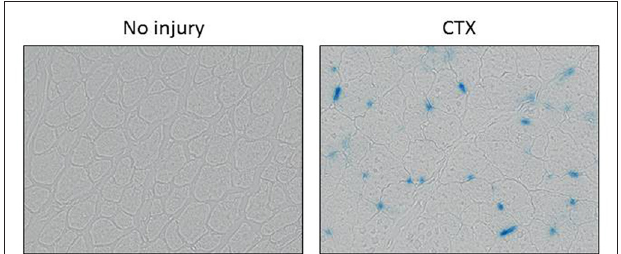
FIGURE 1 | Muscle injury-induced senescence. Senescence-associated β -galactosidase (SA β -gal) staining of the tibialis anterior muscle of a wild-type mouse is shown without injury (left) and 5 days after injury via cardiotoxin (CTX) injection. SA β -gal-stained cells appear blue. Images are courtesy of Haitao Wang, Ph.D., Mayo Clinic, Rochester, MN,